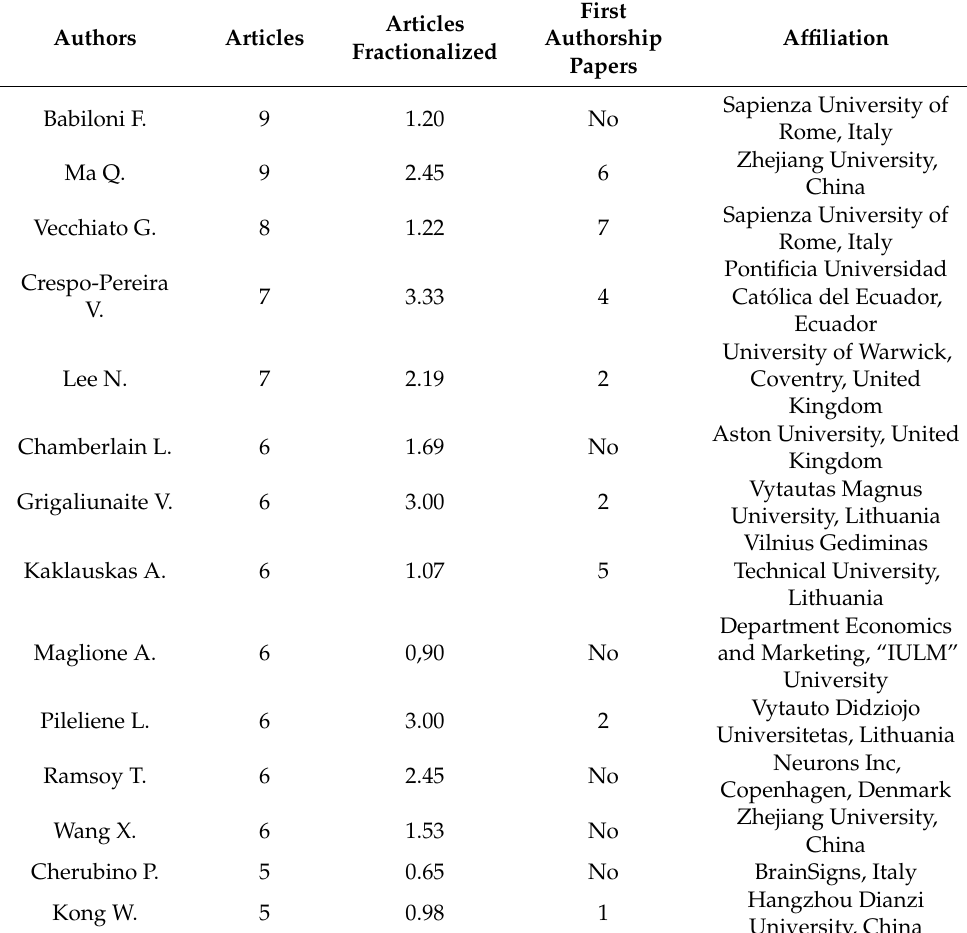
Table 5. Top ten authors’ neuromarketing research